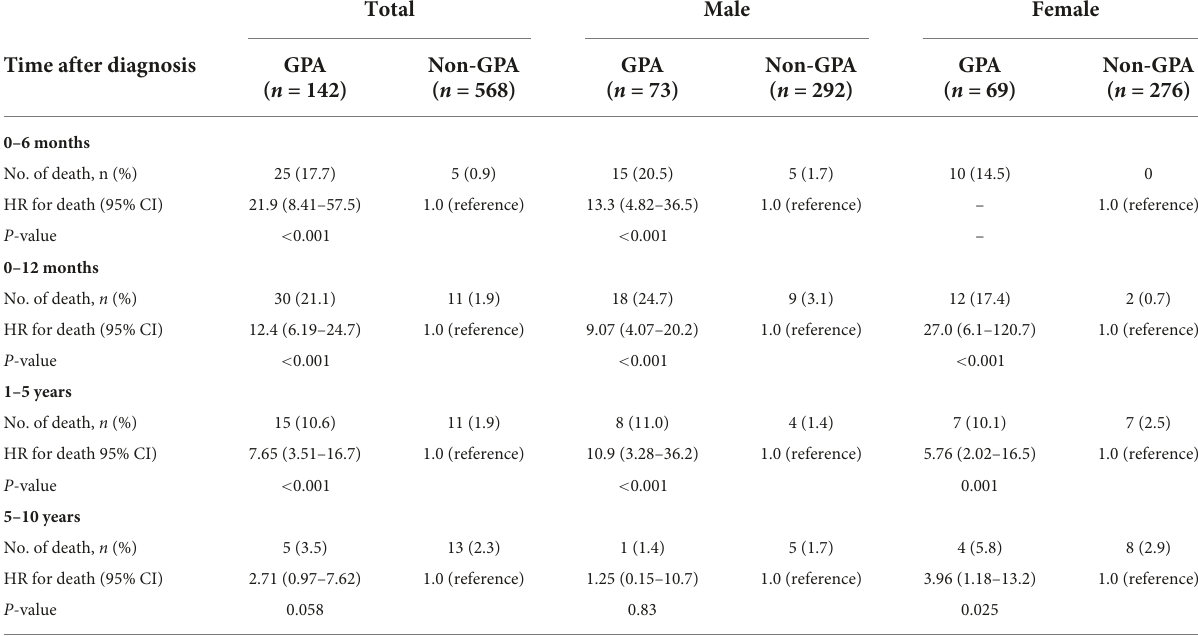
TABLE 4 Risk of death in patients with granulomatosis with polyangiitis (GPA) stratified by the time frame since the start of follow-up and by sex. Total Male Female Time after